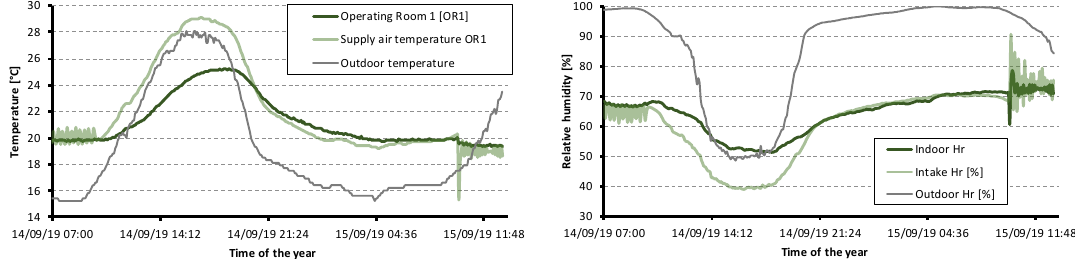
Figure 7. Temperature and RH in OR1 during the second experimental data campaign.